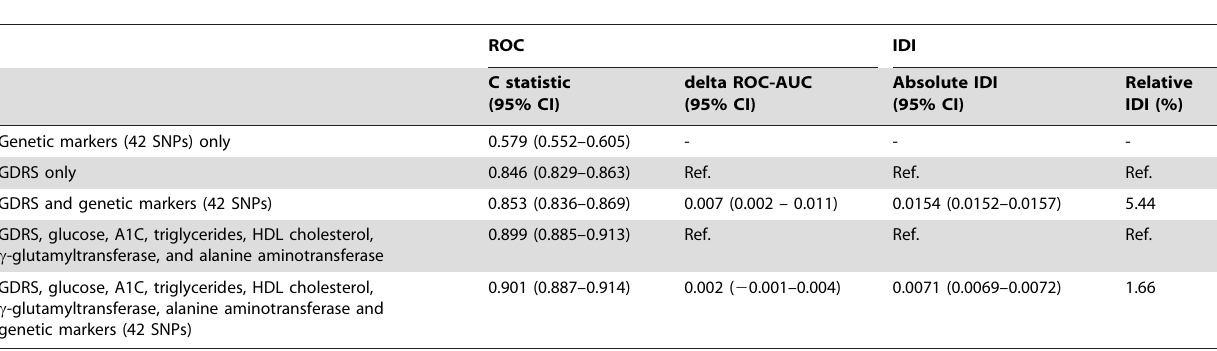
Table 2. Improvement in Discrimination by Adding Genetic Information to the GDRS and Metabolic Biomarkers in the Case-Cohort of